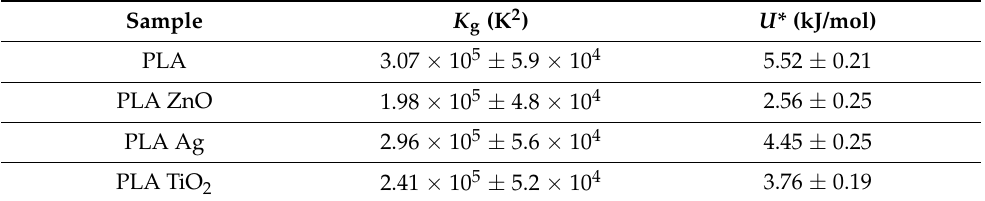
Table 2. Calculated Kg and U * values according to the Hoffman–Lauritzen theory combined with the isoconversional approach (R 2 ≥